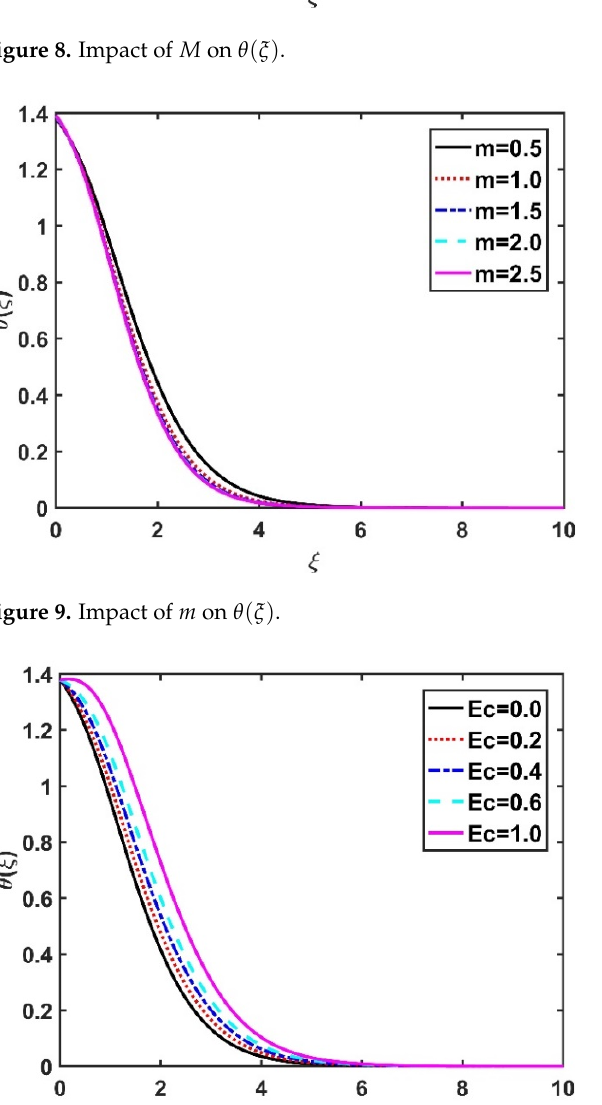
Figure 11. Impact of 𝑅 on 𝜃(cid:4666)𝜉(cid:4667) . Figure 12. Impact of 𝑁𝑏 on 𝜃(cid:4666)𝜉(cid:4667) .